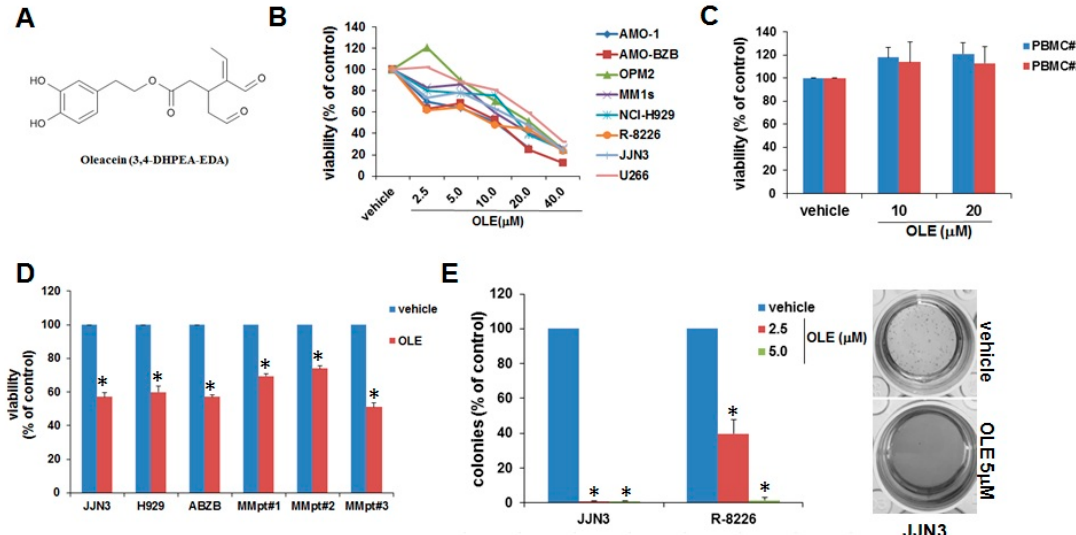
Figure 1. Effects of oleacein on multiple myeloma (MM) cell survival. ( A ) Chemical structure of oleacein. ( B ) Cell viability of MM cell lines as determined by Cell Titer Glo (CTG) assay 48 hours after treatment with increasing doses of oleacein or vehicle (DMSO). ( C ) CTG assay performed on peripheral blood mononuclear cells (PBMCs) from three different healthy donors treated with oleacein for 48 hours. ( D ) CTG assay in MM cell lines and primary CD138 + cells from three MM patients (MM pt#1, #2 and#3) co-cultured on HS-5 stromal cells and treated for 48 hours with 5.0µM oleacein. ( E ) Colony formation assay performed on MM cell lines treated for 14 days with oleacein; representative pictures of JJN3 colonies at day 14 are shown in the right panel (5× magnification). * p < 0.05 as compared to vehicle-treated cells.